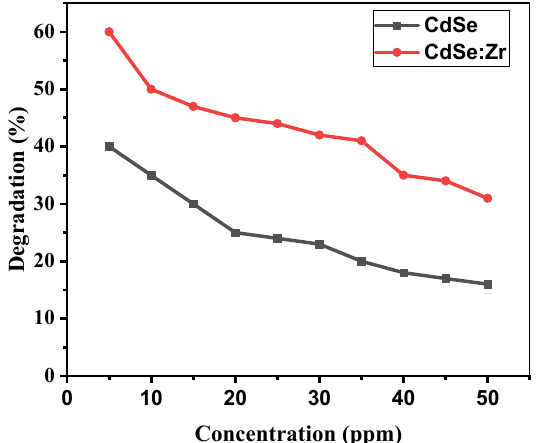
Fig. 6. Effect of initial dye concentration on the photodegradation of IC dye